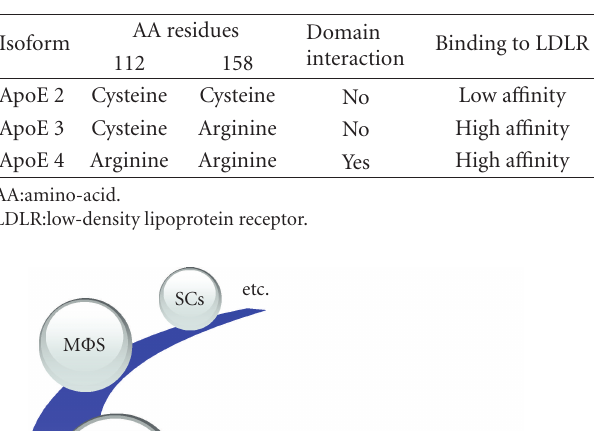
that both apoE-containing lipoproteins and synthetic apoE peptides could inhibit antigen—and mitogen-stimulated T lymphocyte proliferation by downregulating DNA synthesis and by reducing phospholipid turnover in T cells [25–27], as well as modifying the function of interleukin(IL-2) receptor or modifying intracellular signaling pathways [28, 29]. Fur- thermore, apoE can downregulate the T helper (Th 1) 1 cell-